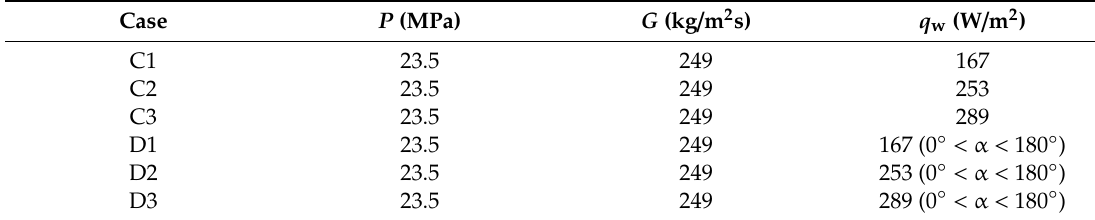
Table 1. Initial / boundary conditions of simulations.